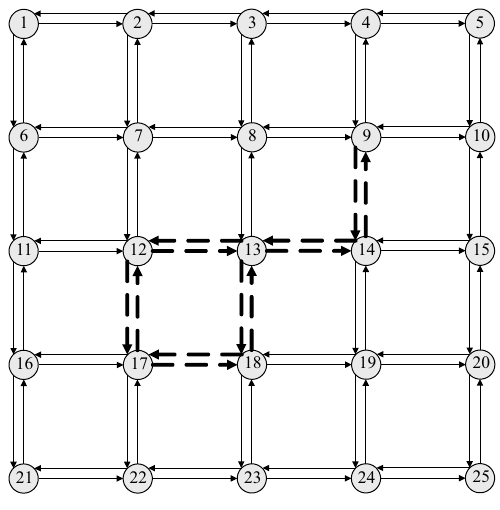
Fig. 13. Optimal charging area design